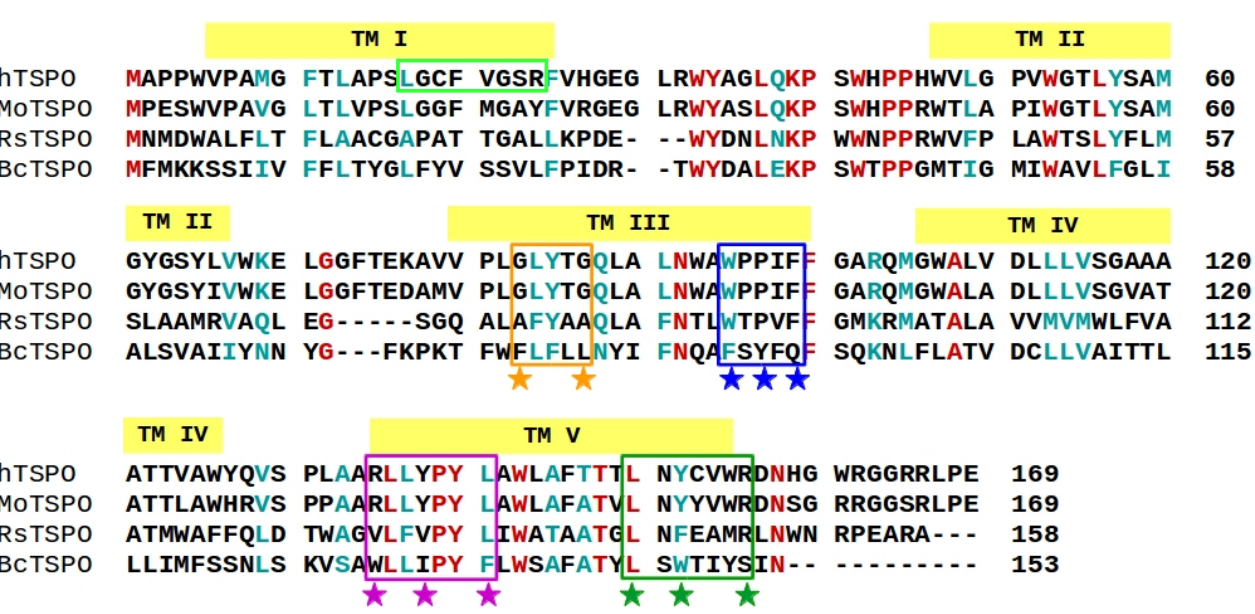
Figure 1. Multiple sequence alignment of TSPO from different organisms: human TSPO ( h TSPO), Mus musculus ( Mo TSPO) [36], Rhodobacter sphaeroides ( Rs TSPO) [35], and Bacillus cereus ( Bc TSPO) [34]. For the last three proteins, ex- perimental structural information is available. Semi-conserved positions with more than 50% consensus according to ClustalO [46] are highlighted in cyan, while highly conserved positions with more than 90% consensus are shown in red. The oligomerization motif G83XXXG87 is indicated by the orange stars and rectangle. The W95XPXF99 motif is depicted with the blue stars and rectangle. The cholesterol-binding motif CRAC and its “mirror code” CARC are marked by dark green and violet rectangles and stars, respectively. The CRAC-like motif in TM I is highlighted by the light green